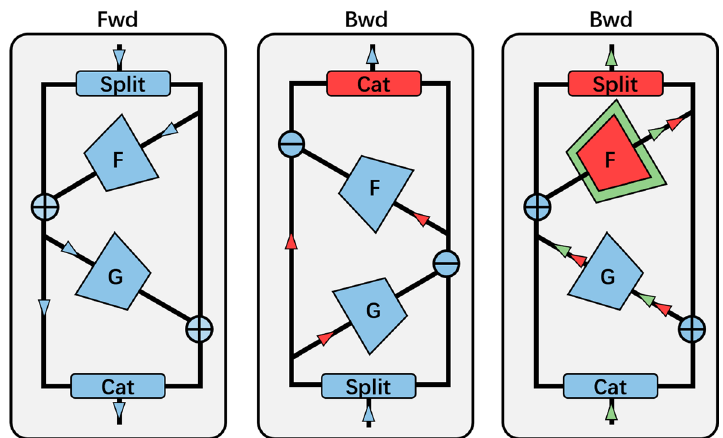
Fig. 9 Illustration of the backpropagation process through a reversible block of our proposed hybrid architecture. In the forward pass (left), activations are propagated forward from top to bottom. The activations are not kept in live memory as they are to be recomputed in the backward pass so that no memory bottleneck occurs. The backward pass is made of two phases: first the input activations are recomputed from the output using the reversible block analytical inverse (middle). This step allows to reconstruct the input activations with minimal reconstruction error. During this step, hidden activations are not kept in live memory so as to avoid the local memory bottleneck of the reversible block. Once the input activation recomputed, the gradients are propagated backward through both modules of the reversible blocks (right). During this second phase, hidden activations are recomputed backward through each module using the layer-wise inverse operations, yielding minimal memory